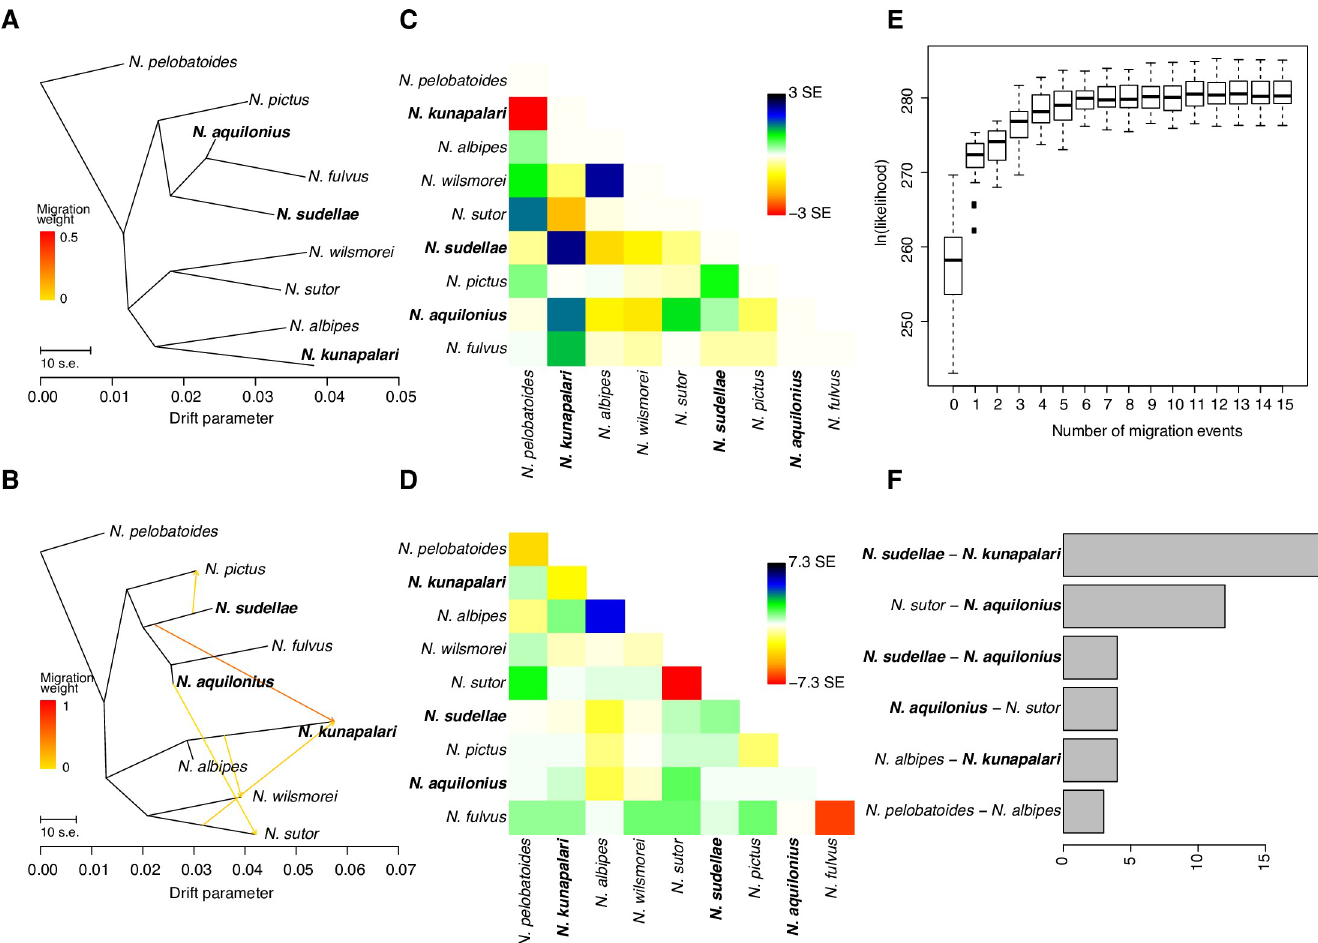
Fig 3. Widespread introgression between Neobatrachus species. (A) Bifurcating maximum likelihood tree produced by TreeMix. (B) Example of a graph produced by TreeMix with 5 allowed migration events. (C) Scaled residual fit between observed data and predicted model in (A). Plot shows half of the residual covariance between each pair of populations divided by the average standard error across all pairs. Positive residuals represent populations where the model underestimates the observed covariance, meaning that populations are more closely related to each other in the data than in the modeled tree. Such population pairs are candidates for admixture events. Similarly, negative residuals indicate pairs of populations where the model overestimates the observed covariance. Overall, the residual plot of the model suggested that model fit could be improved by additional edges (migration events). (D) Scaled residual fit between observed data and predicted model in (B). Compared to Fig 3C this suggests that, although the complexity of the species relatedness is not fully represented by the model, major gene flow events and their direction were probably captured. (E) Box plots of 30 runs of TreeMix (each started with a different seed for random number generation) likelihood at different numbers of allowed migration events; saturation starts after 3 additional migration edges. (F) Bar plot showing the number of times a particular directional migration event was inferred in 30 TreeMix runs with 5 migration events allowed. We show only the events which were inferred more than